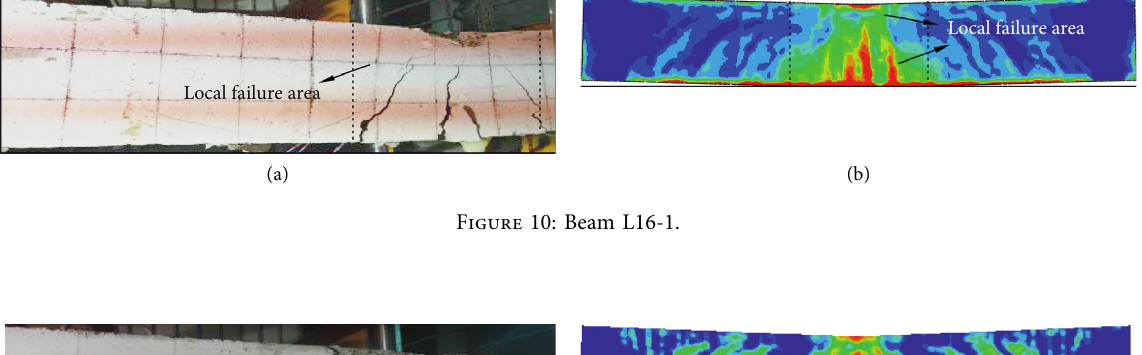
Figure 11: Beam L16-3.